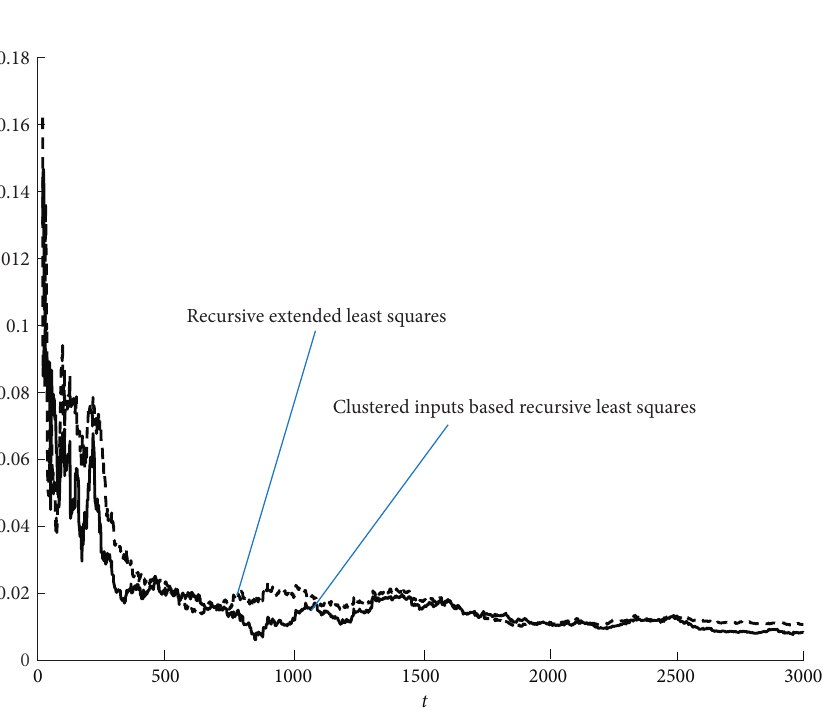
Figure 9: The parameter estimation error δ versus time t for σ 2 � 0 . 40 2